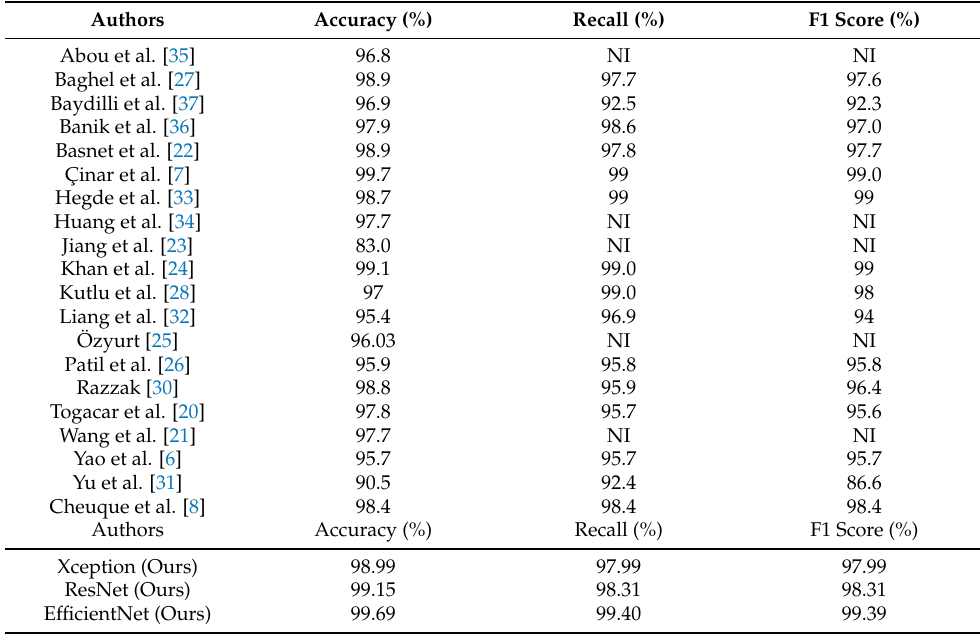
Table 4. A quantitative comparison of the performance of the presented WBC classification approach with that of existing SOTA methods. NI: Not